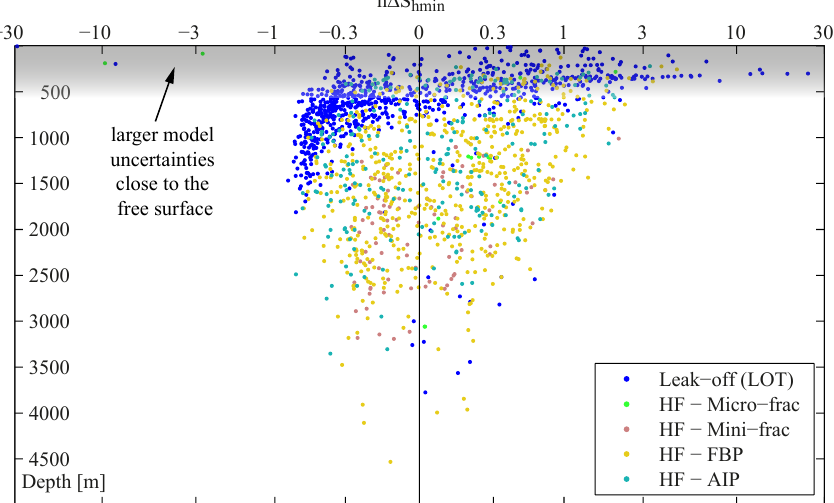
Figure 19. The distribution of the normalized (cid:49)S hmin vs. depth, the measurement method is colour coded. Results close to the surface up to about − 500m (indicated by greyish haze) have to be interpreted with care, as interpolation of the integration points to the nodes of the finite elements at the surface is problematic. Note that shallow ( < − 500m) leak-off tests (LOT) deliver systematic higher magnitudes than the stress model. In contrast to that are deeper ( > − 500m) LOT data, which have systematically smaller magnitudes as the model. Hydraulic fracturing (HF) data are unconcerned from such systematic